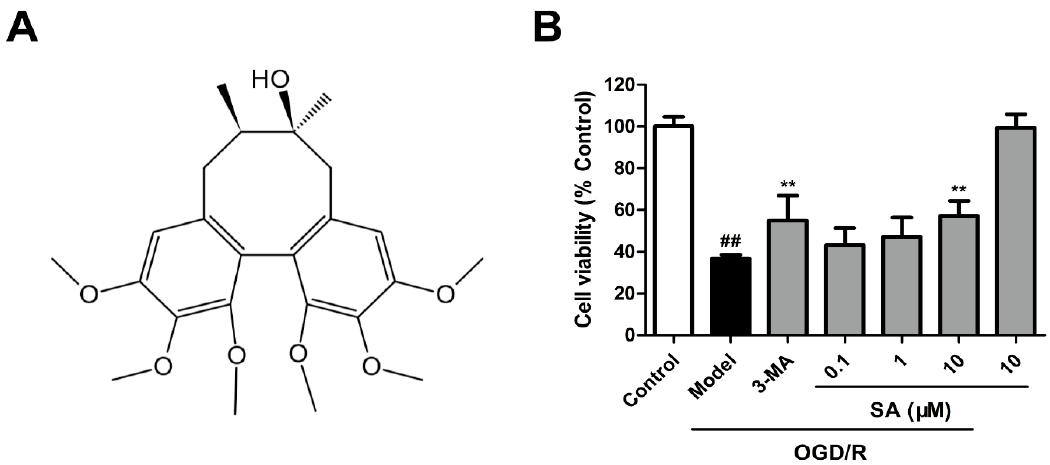
Figure 1. Schizandrin A (SA) protects cells against OGD / R injury in PC12 cells. ( A ) The chemical structure of ginsenoside GRb1. ( B ) Cell viability was determined using the MTT assay (n = 6). All data are mean ± SD. ## P < 0.01 vs. Control group; ** P < 0.01 vs. OGD / R group.